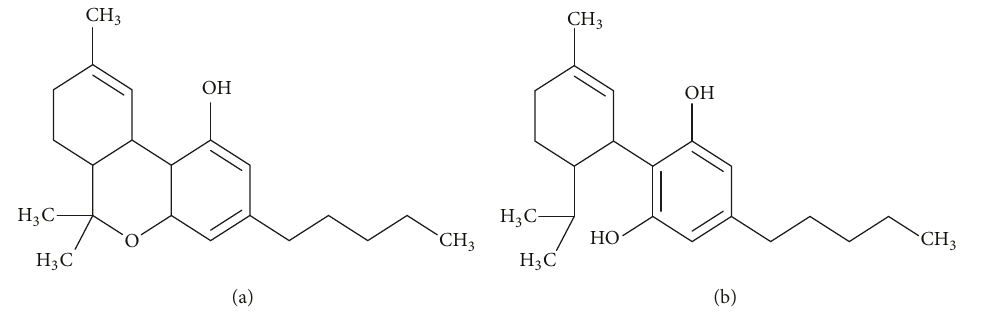
Figure 3: The main structures of Atractylis gummifera L. [14, 15].